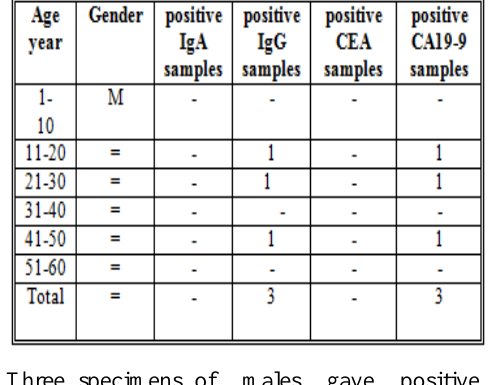
Table (8 ) Age distribution of anti H.pylori IgG and IgA positive and serum markers CEA and CA19-9 in males patients